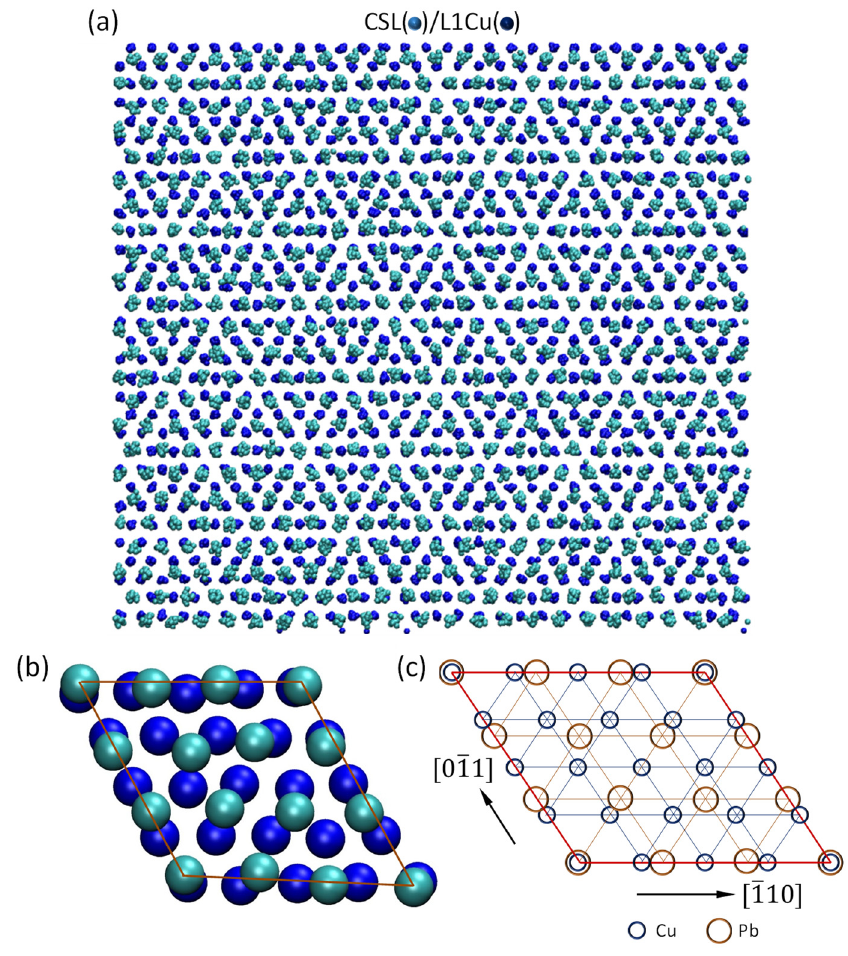
Figure 4. Formation of coincidence site lattice (CSL) during prenucleation in the Pb( l )/Cu( s ) system equilibrated at 625 K; ( a ) time-averaged atomic positions (top view) of CSL Pb layer superimposed on that of L1Cu; ( b ) snapshot of CSL/L1Cu showing the atomic arrangement in the CSL unit cell; ( c ) schematic illustration of CSL unit cell showing the matching rule, 3 d Pb = 4 d Cu , where d is the atomic spacing along the <011> direction.